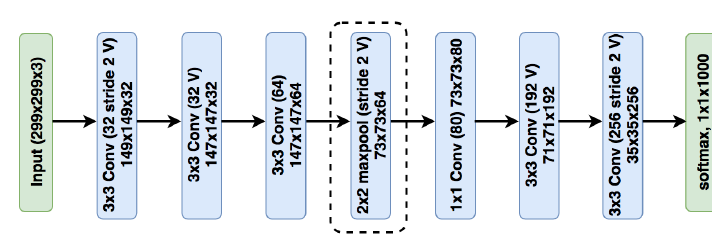
Figure 10. Model 1: Architecture of proposed network 1 for object detection.